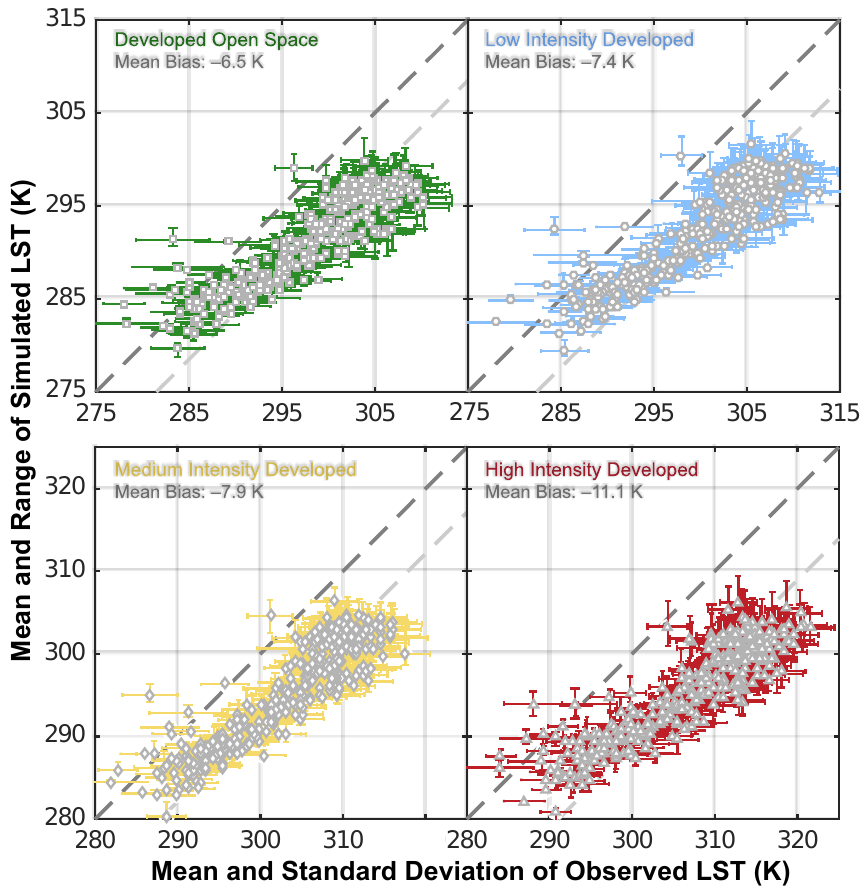
Figure 4. Comparison of simulated and observed Landsat LST for all overpass times. Horizontal bars represent the standard deviation of values observed for that scene; vertical bars represent the full range of model results from all simulations. 1:1 and mean bias lines shown as dark and light grey dashed lines, respectively.